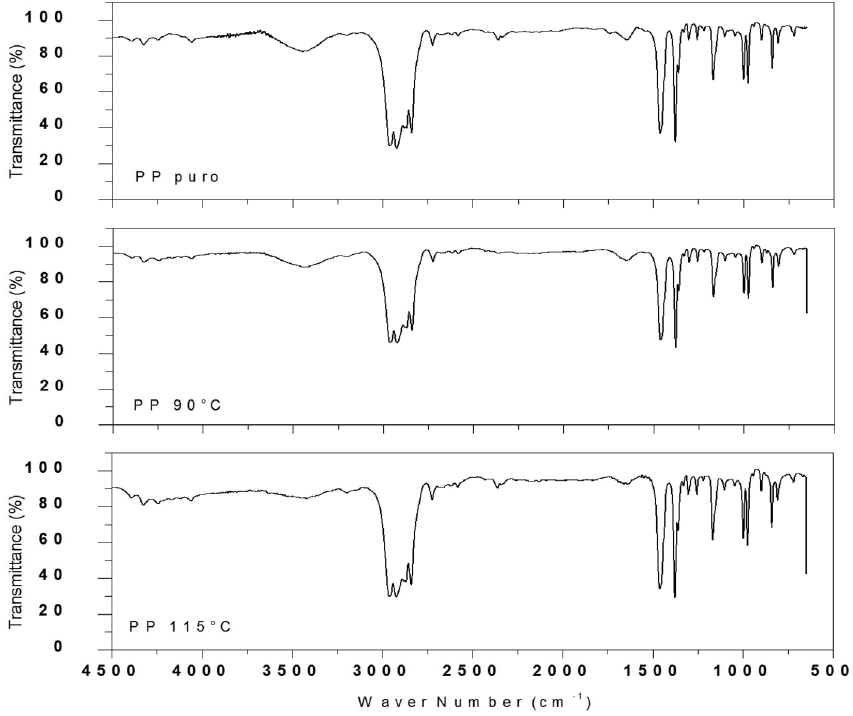
Figure 8. Infrared spectrum for pure PP, 90° PP and 115°C PP.